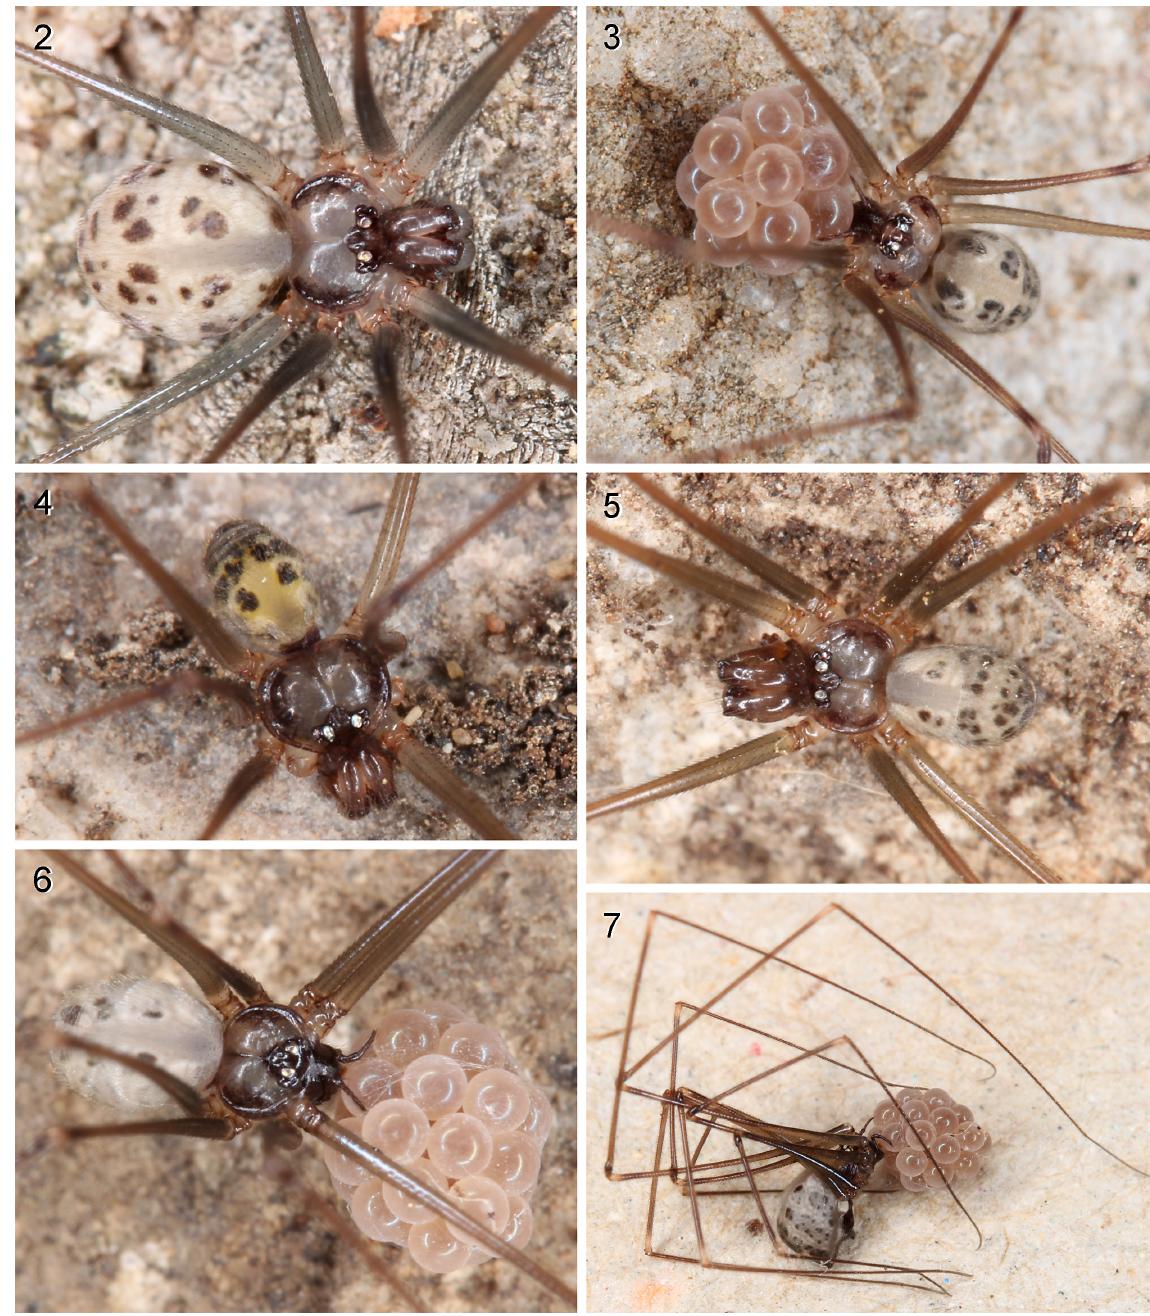
Figs 2–7. Live specimens. — 2–4 . Savarna kaeo sp. nov. ♂♂ from Reclining Buddha Cave and from Tham Sai (2, 4); ♀ with eggsac from Tham Sai (3). — 5–7 . S. kraburiensis Wongprom & Wiwatwitaya, 2015. ♂ , ♀ with eggsac, and ♀ with eggsac after dropping to the ground; all from Tham Phra